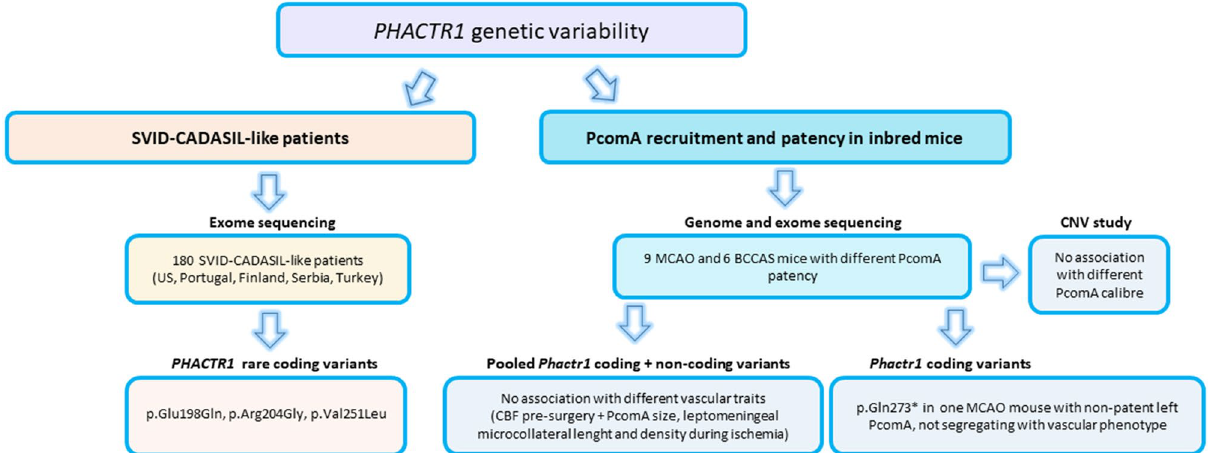
Figure 1. Pipeline followed in the present study. SVID small vessel ischemic disease, US United States, BCCAS bilateral common carotid artery stenosis, ECA external carotid artery, PcomAs posterior communicating arteries, CNV copy number variant, MCAO middle cerebral artery occlusion.